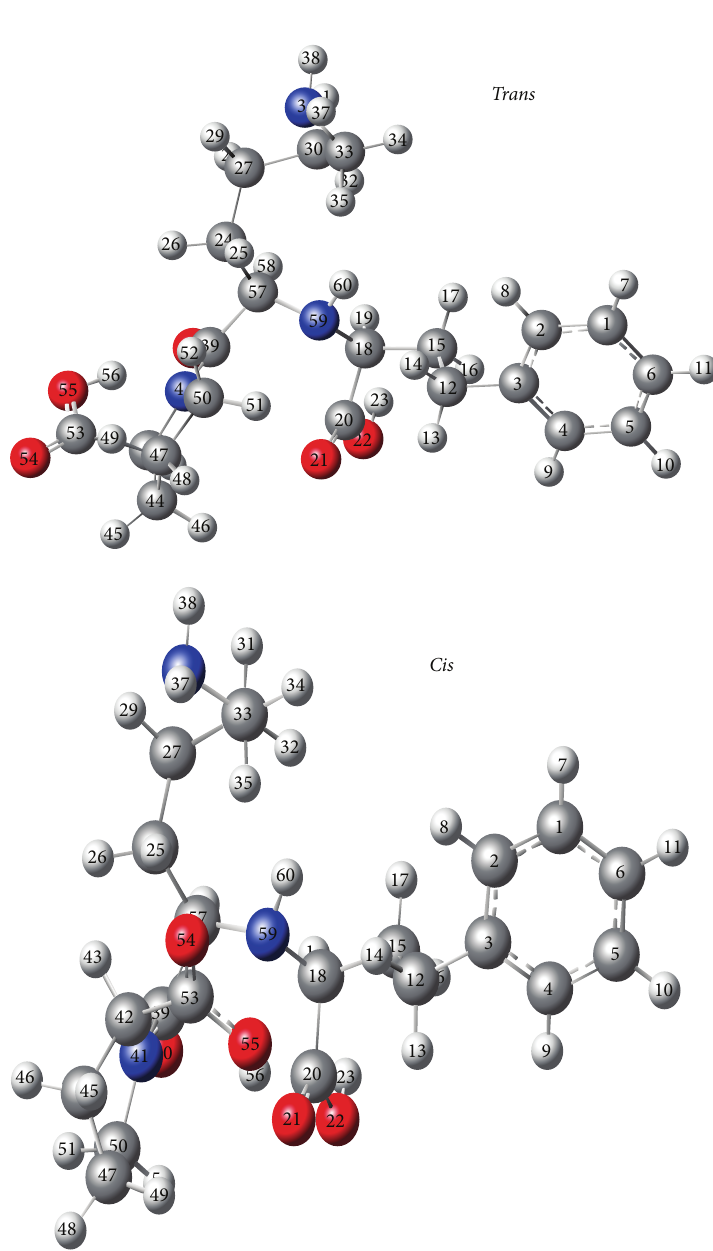
Figure 8: DFT/B3LYP optimized geometries of